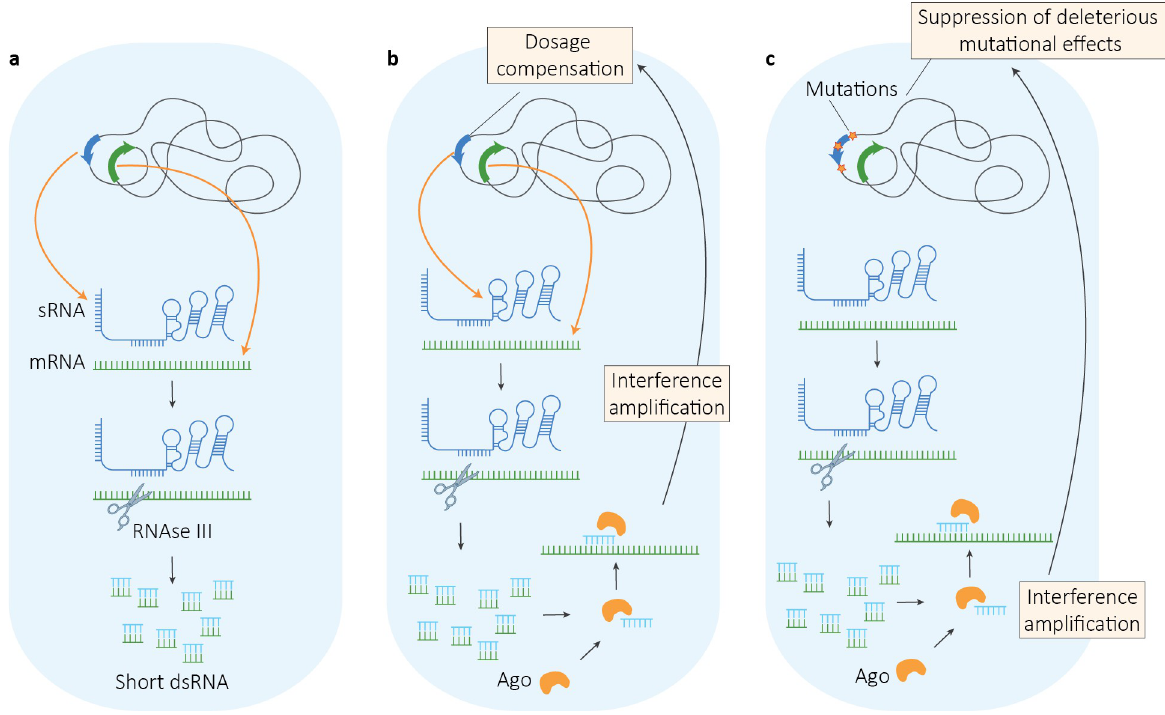
Fig 4. Hypothetical transition from bacterial asRNA gene regulation to eukaryotic RNAi due to CNE. ( a ) asRNAs (not in figure) or sRNAs may lead to the production of short dsRNAs. ( b ) Prior to degradation, the short dsRNAs may interact with cellular proteins such as Ago and become guide RNAs. The slicer activity of Ago may cause an amplification of the interference effect that triggers the down-regulation of the asRNA or sRNA by dosage compensation. ( c ) Mutations that reduce the expression or functionality of the asRNA or sRNA are now likely to appear and accumulate owing to the suppressive effect of Ago, causing irreversibility to this process. Ago, Argonaute; asRNA, antisense RNA; CNE, constructive neutral evolution; dsRNA, double-stranded RNA; RNAi, RNA interference; sRNA, small RNA.